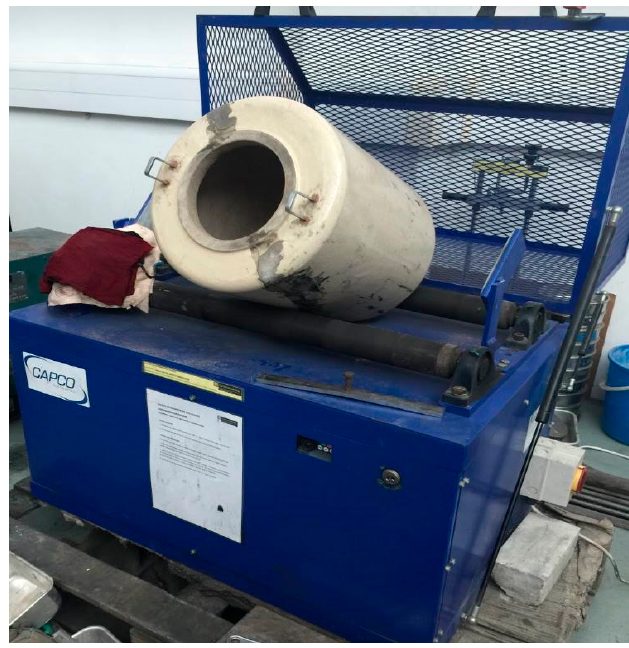
Figure 1. Image of high-energy ball mill.